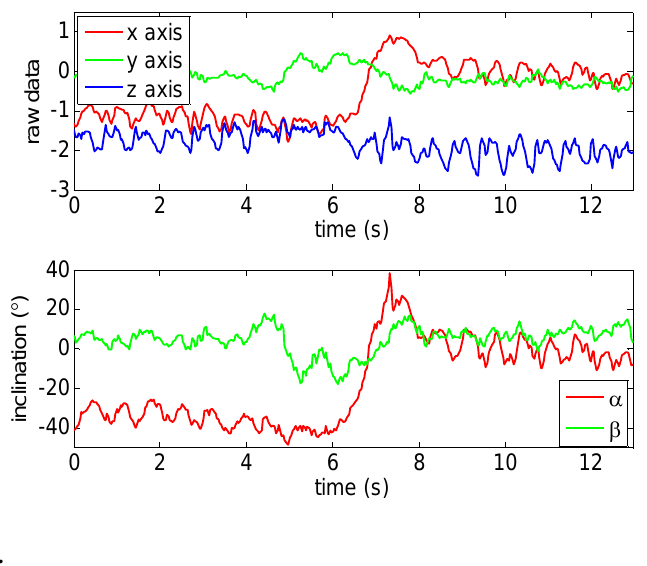
Figure 8. Raw sensor data for each axis and sensor inclination estimate during operation with the electronic white cane.